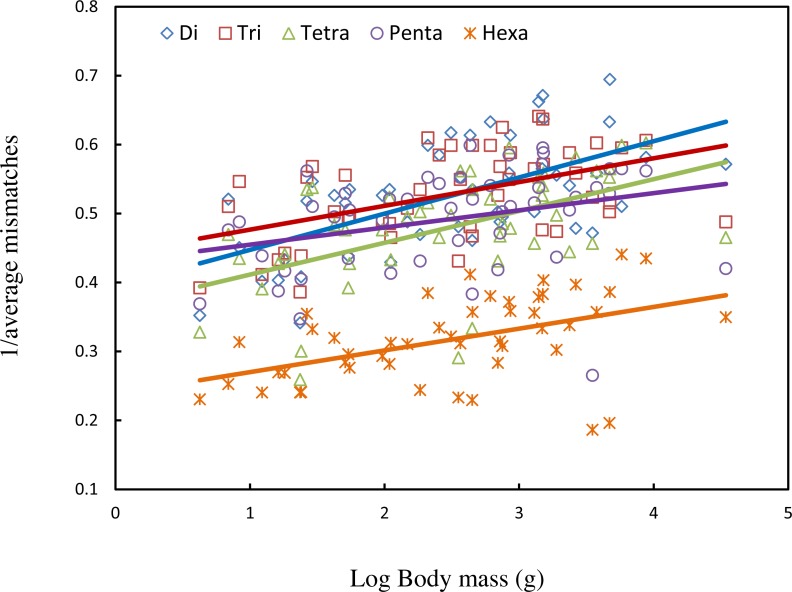
Regression scatterplot of the inverse of the average mismatches of imperfect SSRs in five classes of repeat type on the log of body mass.